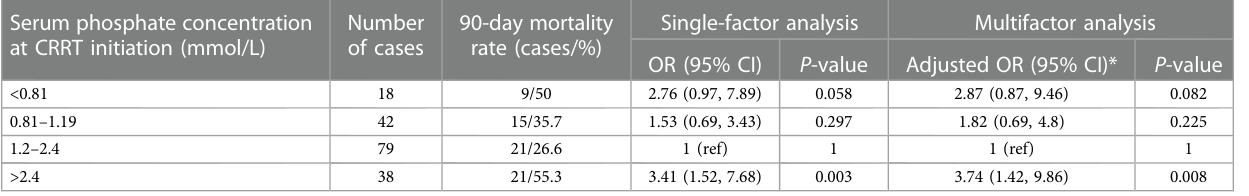
TABLE 2 Relationship between serum phosphate concentration and 90-day mortality rate before CRRT initiation.